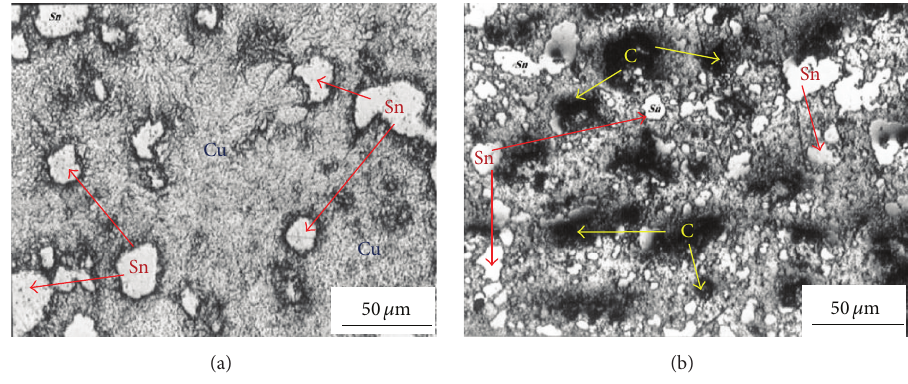
Figure 3: SEM micrographs of heat-treated (a) 90% Cu-10% Sn and (b) 85% Cu-10% Sn-5% C